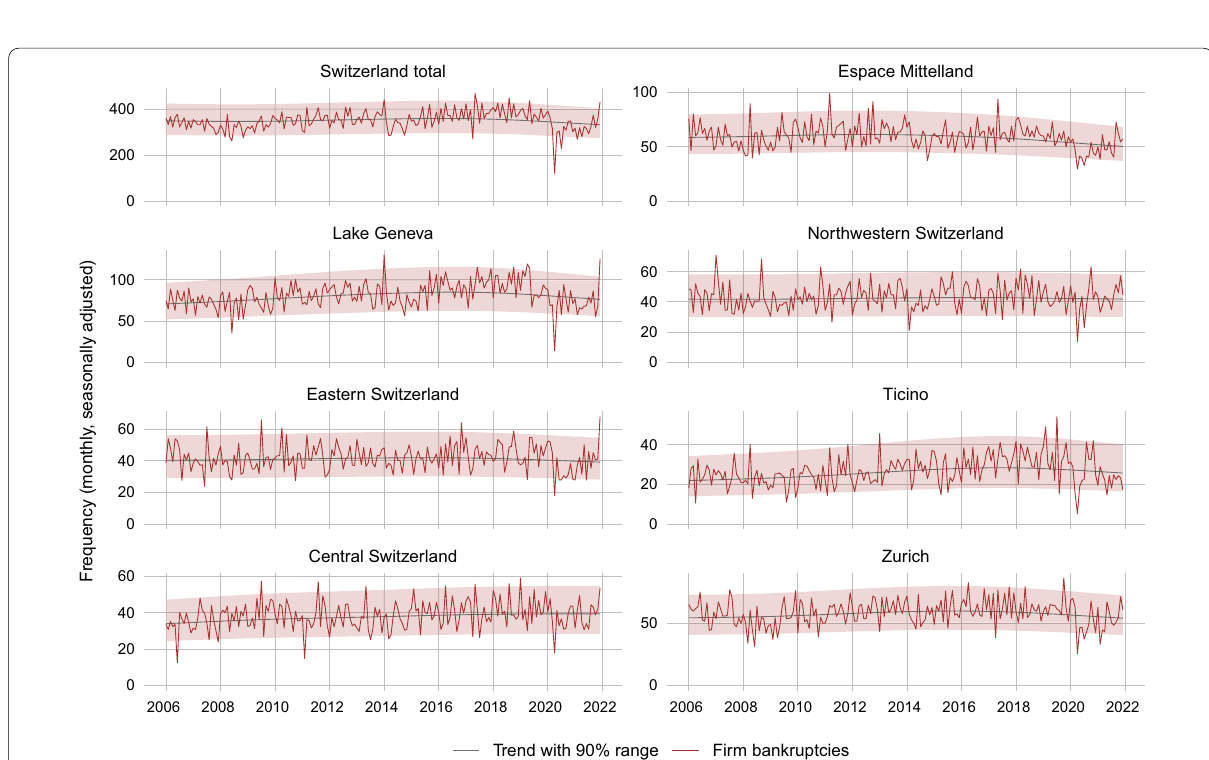
Fig. 9 Monthly frequency of firm bankruptcies at the regional level. Notes : The figure shows the monthly seasonally adjusted frequency of firm bankrupcties in the Swiss greater regions excluding SCO Art. 731b cases, together with a trend and the 90% probability